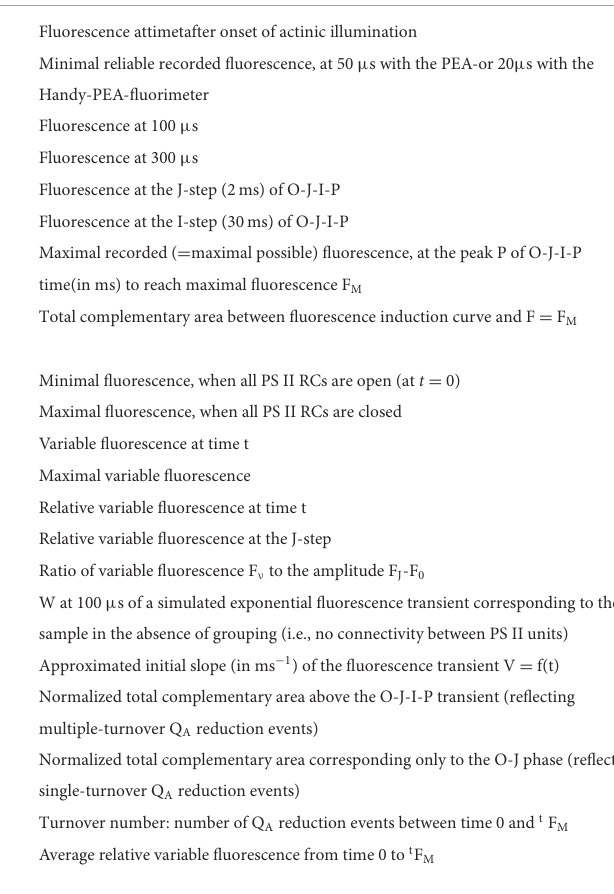
TABLE 1 Definitions, explanations, and calculations of the JIP test parameters used in the present study (adopted from Strasser et al. (2004)). Data extracted from the recorded fluorescence